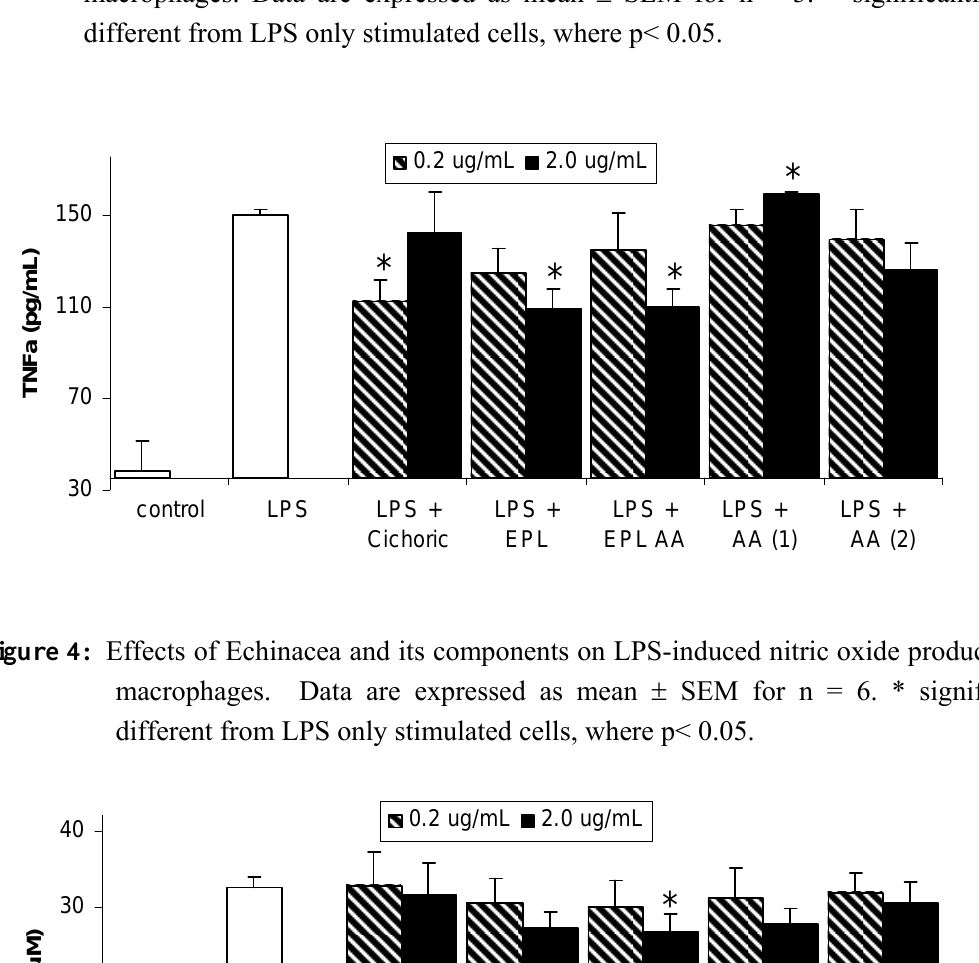
Figure 3: Effects of Echinacea and its components on LPS-induced TNF- α expression in macrophages. Data are expressed as mean ± SEM for n = 3. * significantly different from LPS only stimulated cells, where p< 0.05.